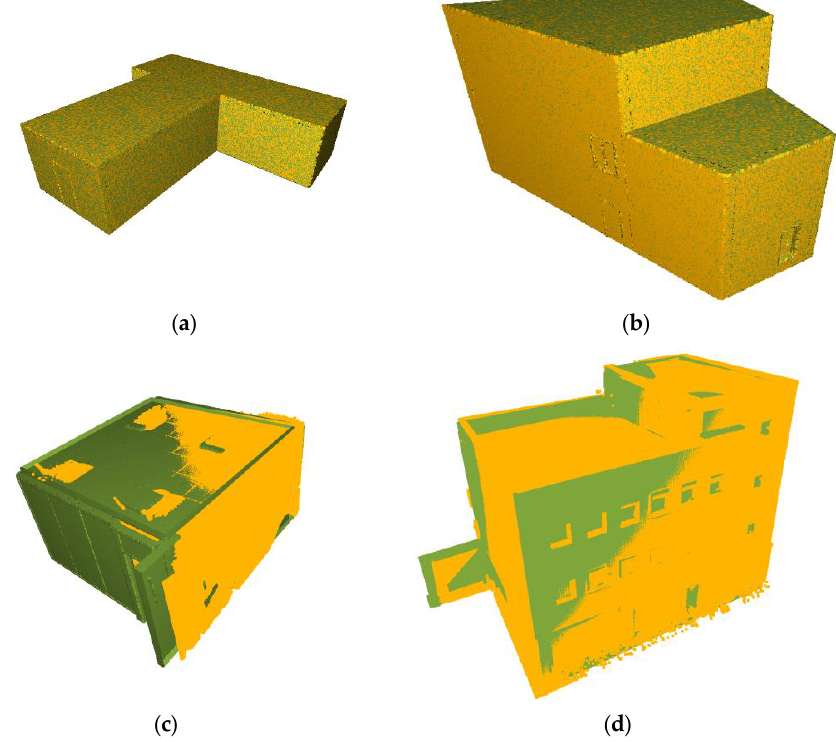
Figure 15. Visualization of registered as-built (yellow) and as-planned (green) models of ( a ) dataset A1, ( b ) dataset A2, ( c ) dataset R1, and ( d ) dataset R2. To evaluate the registration accuracy, the root-means-square errors (RMSE) were computed. Furthermore, the transformed models were also compared with their ground truth models as RMSE is not sufficient as an indicator of registration accuracy [10]. The ground truth models were the same as the as-planned models for the simulated datasets;